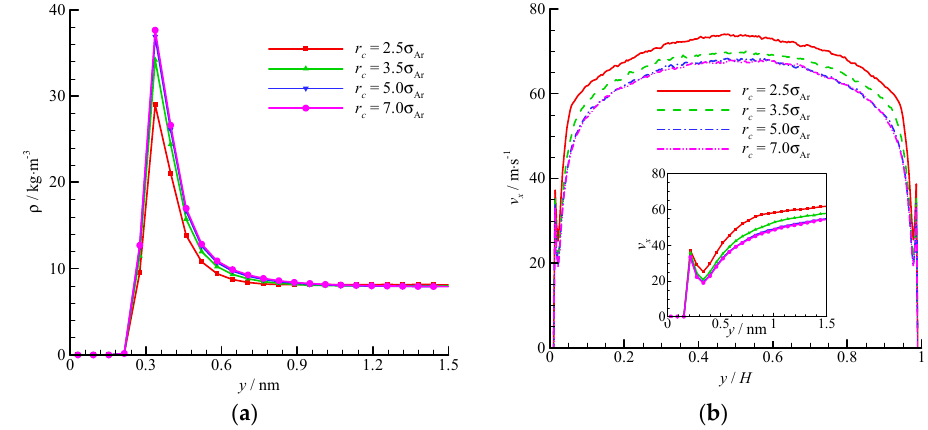
Figure 9. Comparison of density and velocity profiles at different interactional cut-off radii, ( a ) density profile and ( b ) velocity profile. The non-dimensional wall distance (non-dimensionalized by the channel height H ) is used in large figure, and the dimensional wall distance is used in the zoomed-in figure.